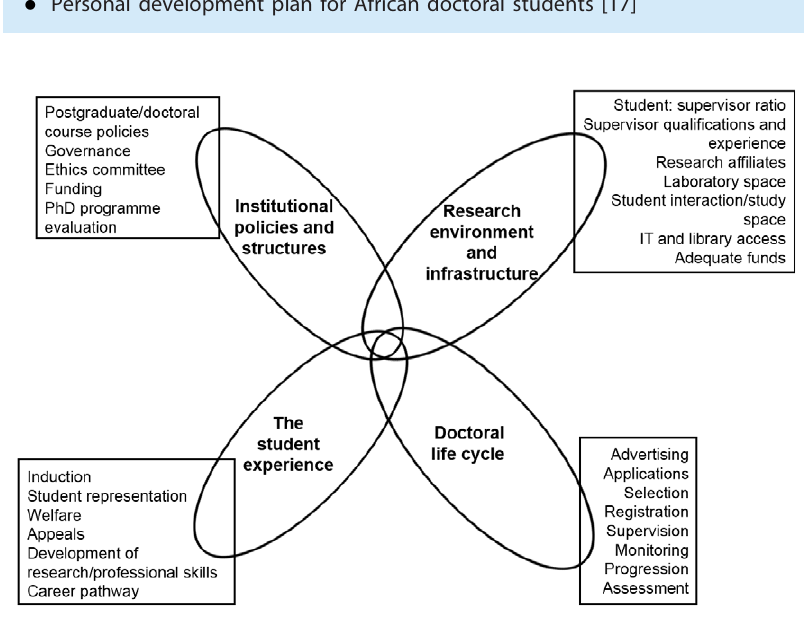
Figure 1. The four components of doctoral programmes, with examples of the constituents of the